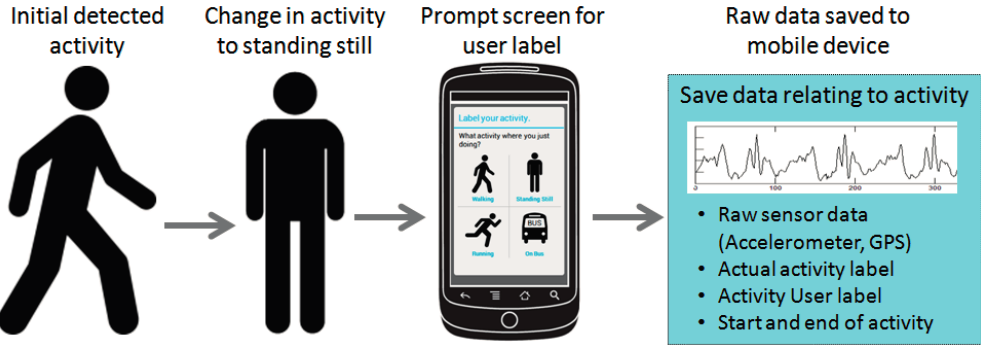
Figure 3. An example of the user interaction with the prompt labeling screen. The AR module detects a change in class from the original activity to standing still. The prompt is then issued for the user to label their previous activity. Raw sensor data is then saved to the mobile device before being uploaded to the cloud for further processing and